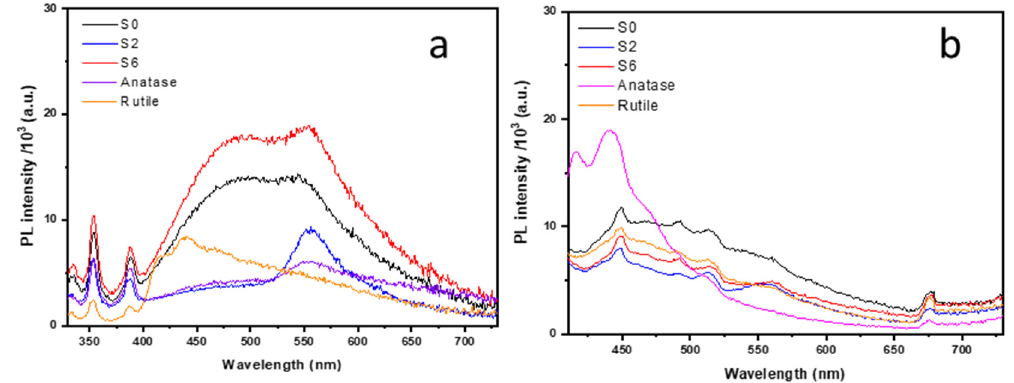
Figure 7. Photoluminescence (PL) spectra of some representative samples (S0, S2 and S6) and samples consisting of anatase phase (SA) and rutile phase (SR), obtained upon excitation at ( a ) 300 nm and ( b ) 380 nm.